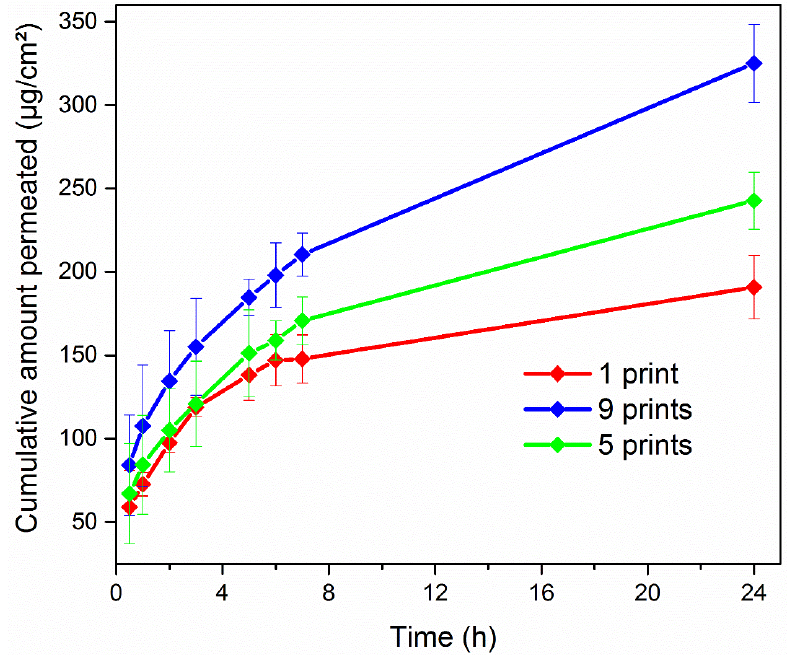
Figure 8. Cumulative transport of DNa across the cellulose membrane.